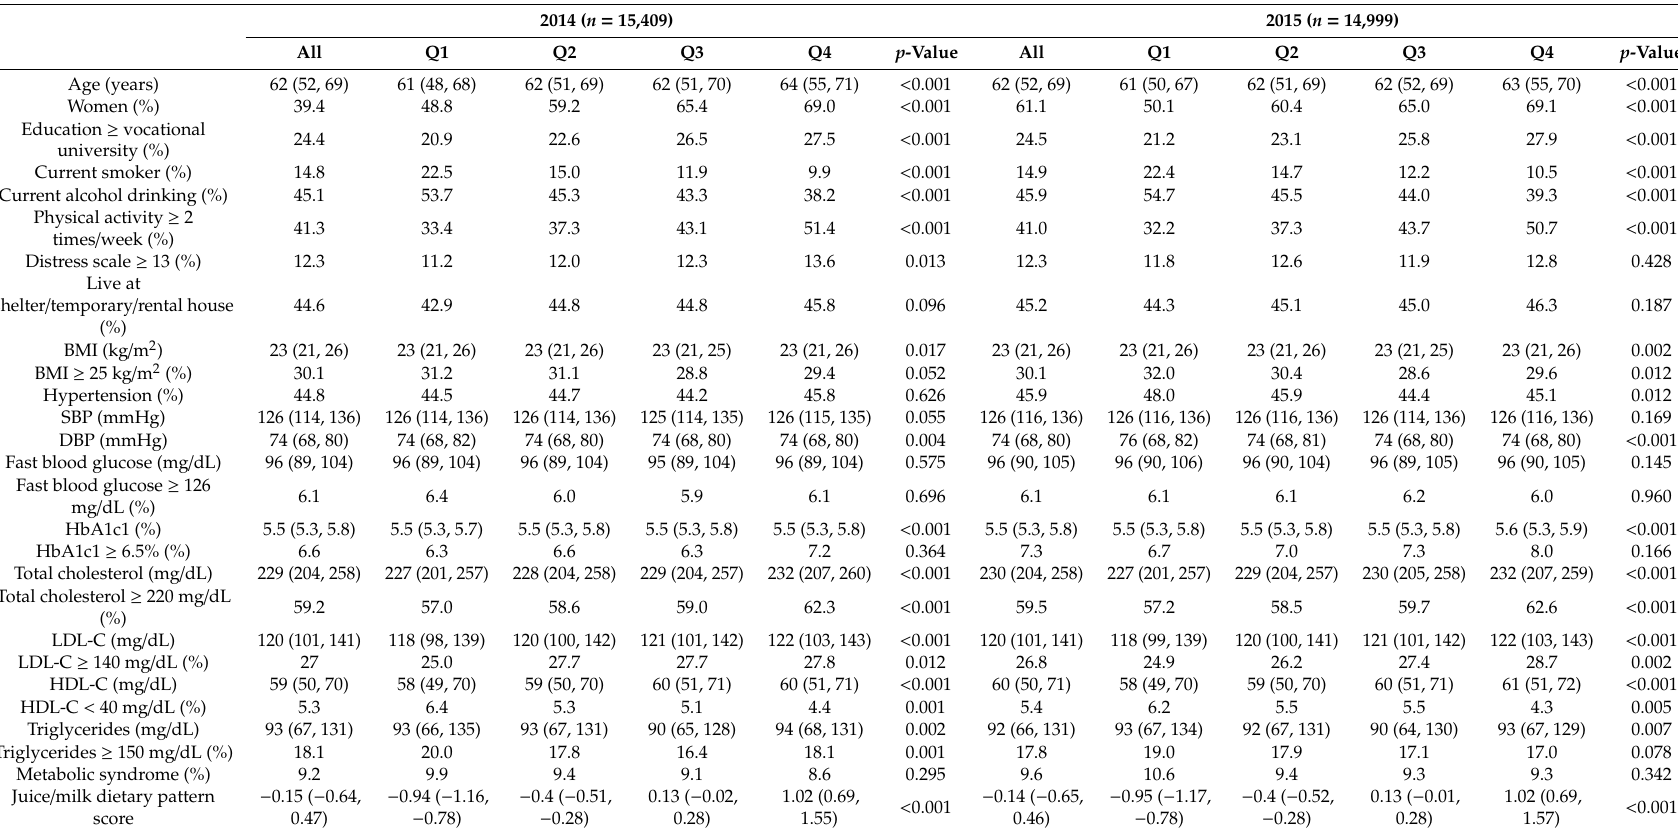
Table 2. Characteristics of participants (2011–2013) and their health checkup results (2014–2015) stratified by the cumulative means of juice / milk dietary pattern